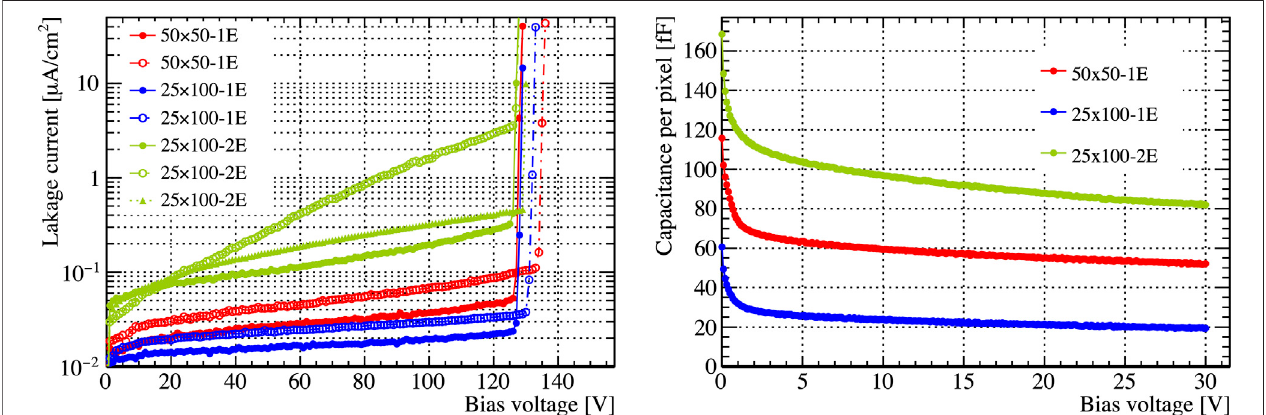
FIGURE 5 | FBK 3D diode measurements performed on wafer at the end of the process on the fi nal metal. I-V (Left) and C-V (Right) curves are shown. A systematic uncertainty, not shown in the fi gures, of less than 10% has been estimated for both current and capacitance measurements, due to temperature variations and the LCR circuit, respectively. The systematic uncertainties due to the test instrument for the considered voltage and current range are smaller than